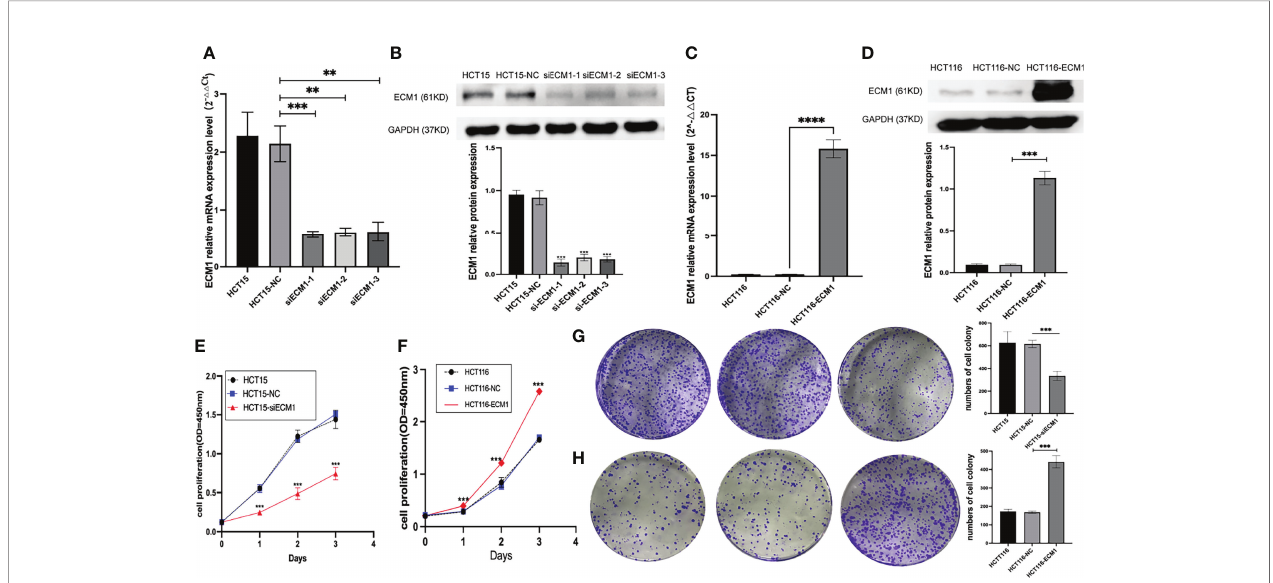
FIGURE 2 | ECM1 regulates proliferative activity in CRC cells. (A, B) . Western blotting and qPCR were performed to assess ECM1 knockdown. (C, D) . Western blotting and qPCR were employed to assess ECM1 expression in CRC cells following its overexpression. CCK-8 and colony formation assays were used to assess cellular proliferation, revealing that (E, G) ECM1 knockdown suppressed HCT15 cell proliferation relative to control cells, while (F, H) ECM1 overexpression enhanced HCT116 cell proliferation. Data are means ± SD (**P < 0.01, ***P < 0.001, ****P <